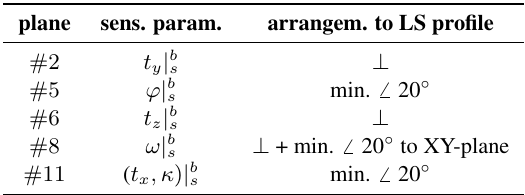
Table 1. Arrangement of the RP in the laser scanner (LS) frame with respect to the sensitive